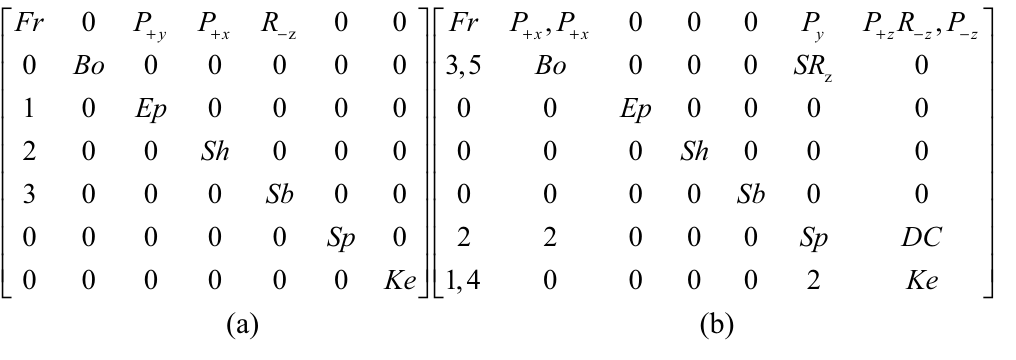
Figure 7. Topology matrix of sliding end-plate